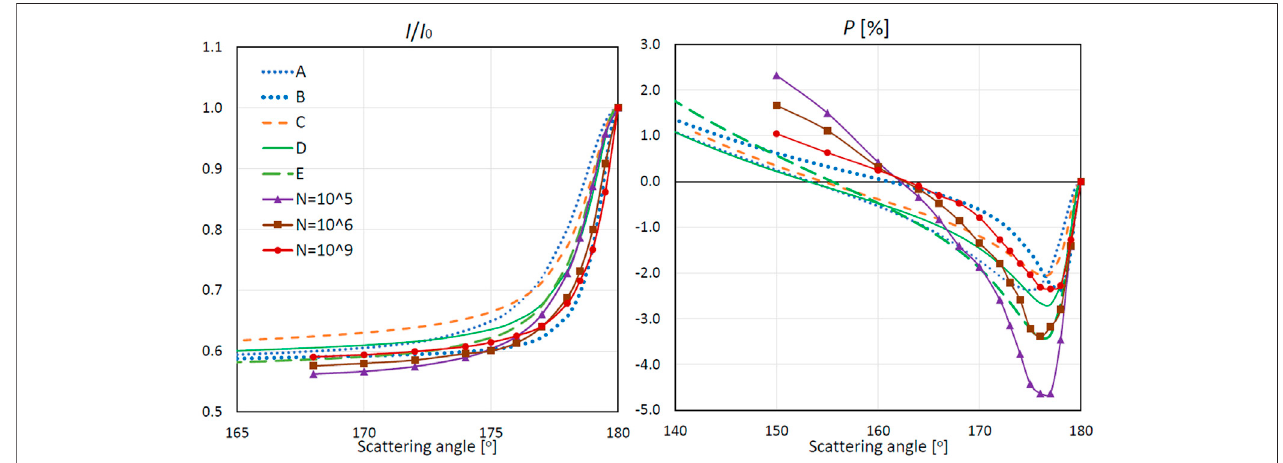
FIGURE 5 | The same as in Figure 4 but compared to the speci fi ed models for a cloud of particles considered by Penttilä et al. (2021).